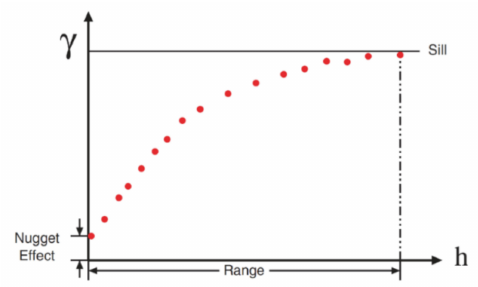
Figure 4. An example of experimental